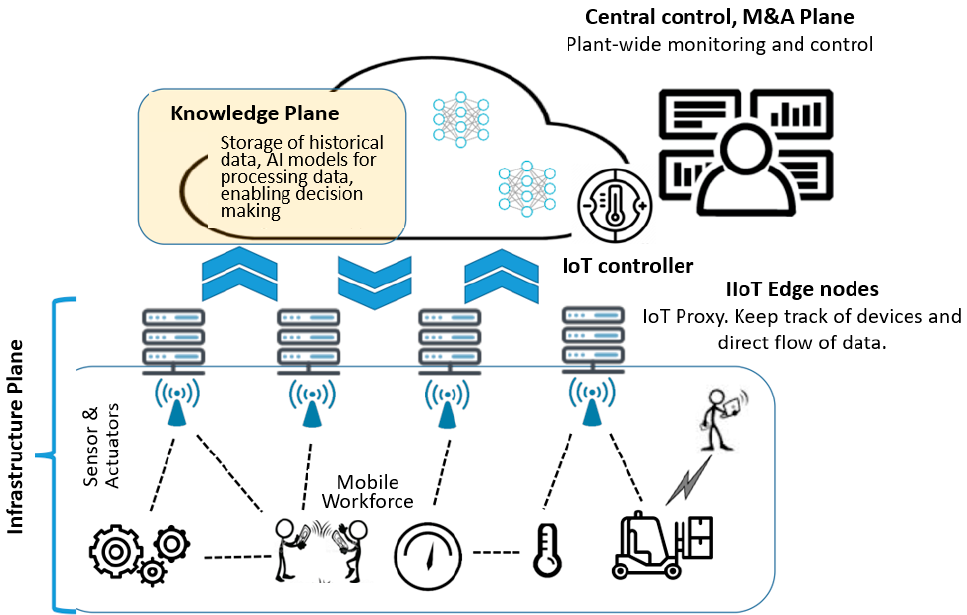
Figure 3. Example application where a mobile workforce is supported in an Industry IoT (IIoT) scenario. Huge amounts of data generated by equipment need to be collected both for long-term storage and analysis at a low resolution and for mobile workers used locally at high resolution (near real-time). An IoT-proxy can be installed in the IIoT Edge nodes to control the data transmission frequency to the clouds / control center. An IoT controller can be realized in the control center, and the cloud services can be realized in the knowledge plane.